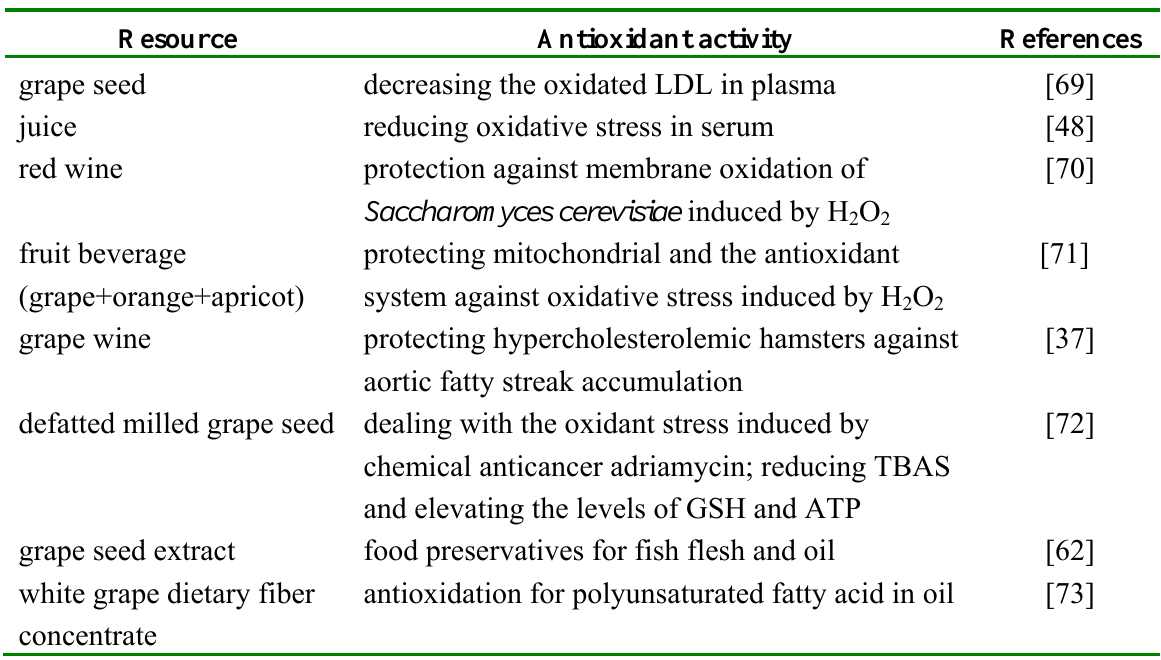
Table 3. Antioxidant activities of the extracts from grapes and its